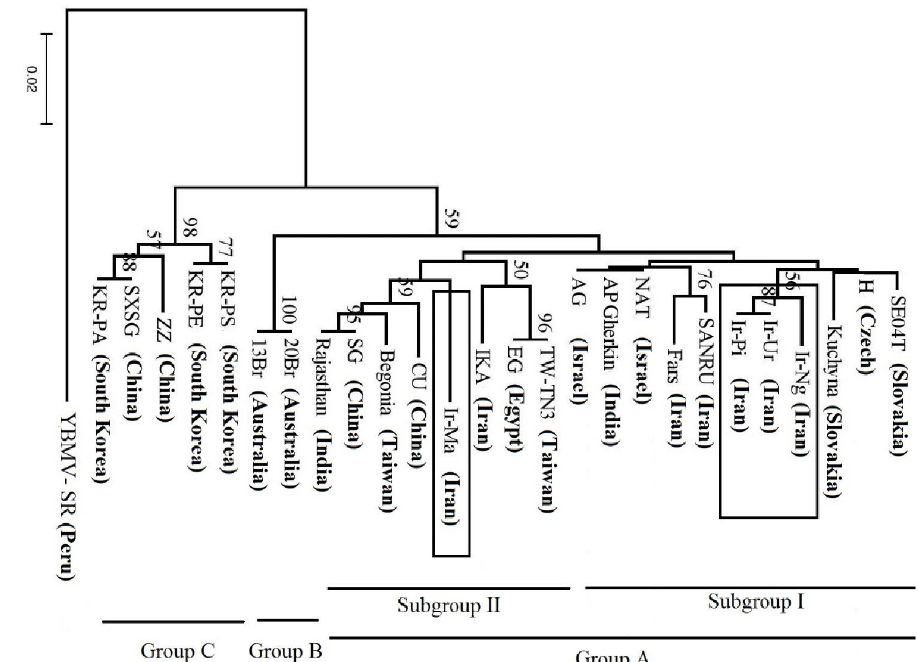
Fig. 4 . Maximum-likelihood tree constructed based on nucleotide sequences of the amplified 350 bp fragment from 27 Zucchini yellow mosaic virus isolates including isolates from Iran (bolded). Multiple sequence alignments were generated with the MEGA program Version 6. Bootstrap values (>50%) are shown on the nodes. Yam bean mosaic virus (JN190431) was included as an